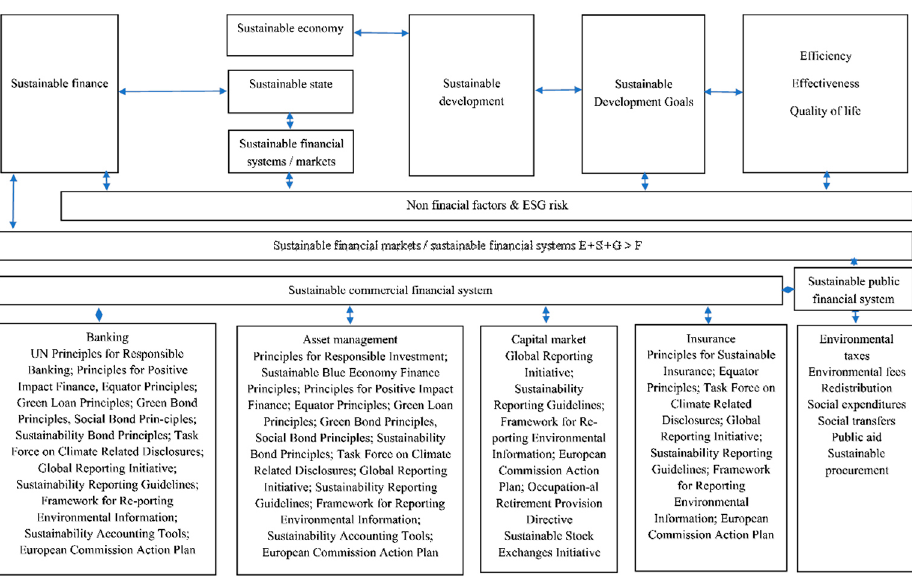
Figure 10. Sustainable finance model for sustainable economy – governance